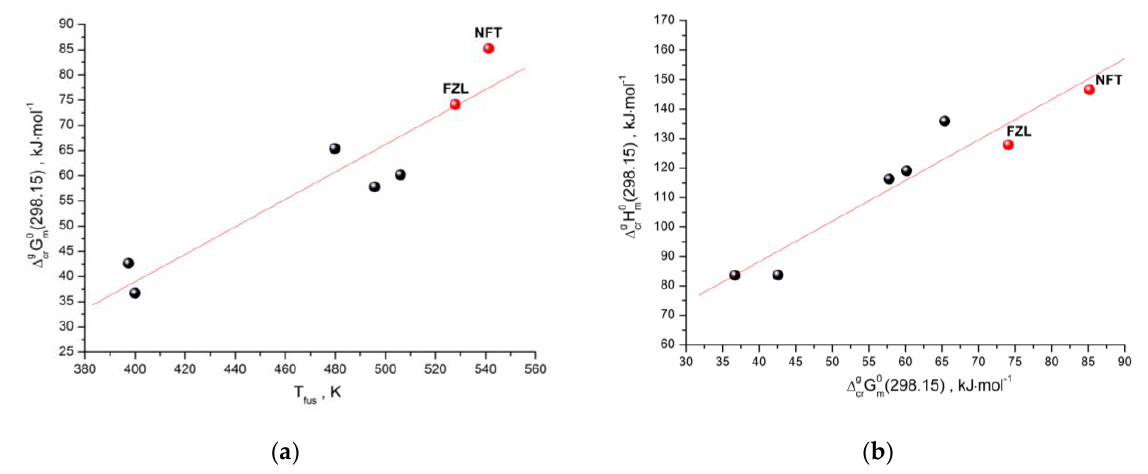
Figure 6. ( a ) Correlation between melting temperature and sublimation Gibbs energy; ( b ) Gibbs energy and enthalpy of sublimation for the set of compounds. The red circles represent results for the studied compounds.